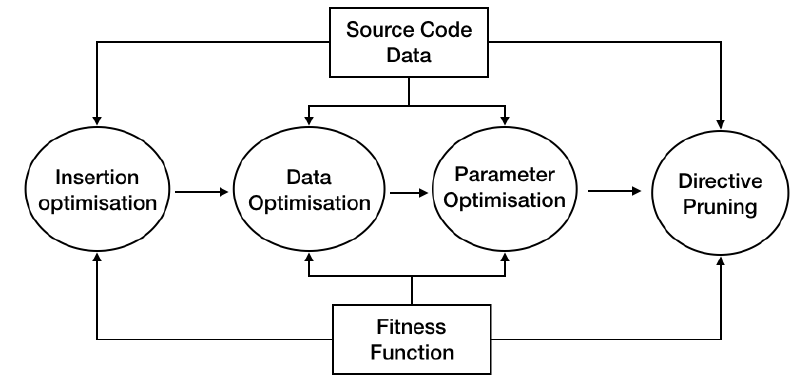
Figure 4: The Architecture of